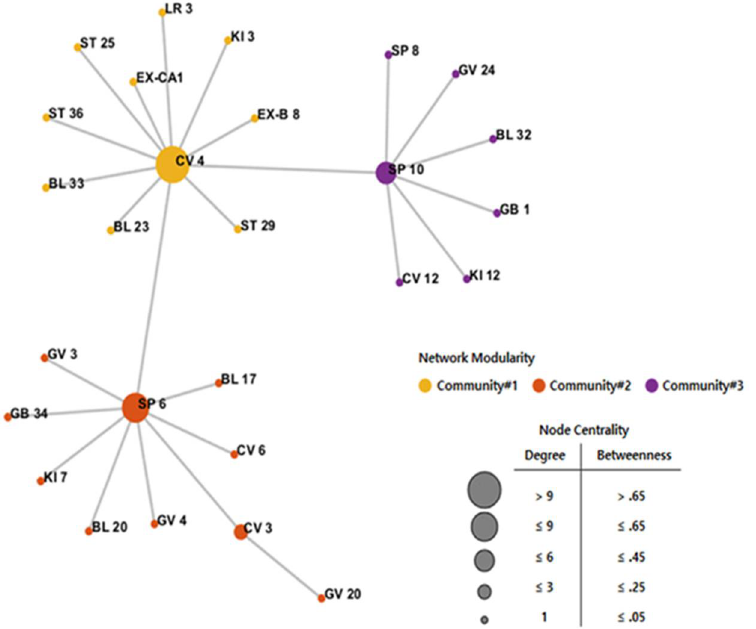
Figure 4. Acupoint combination network. The acupoint combination network simplified the network structure using the minimum spanning tree algorithm. The network consists of three communities centered on CV4, SP6, and SP10 acupoints. The size of each acupoint node was expressed as node centrality based on both degree and betweenness ranges.